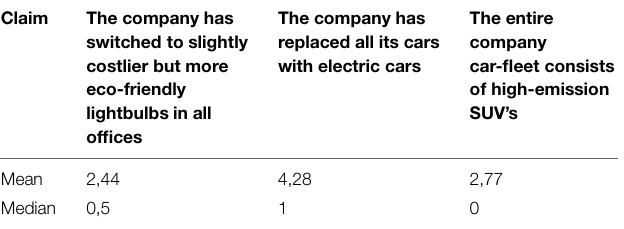
TABLE 3 | Diluting